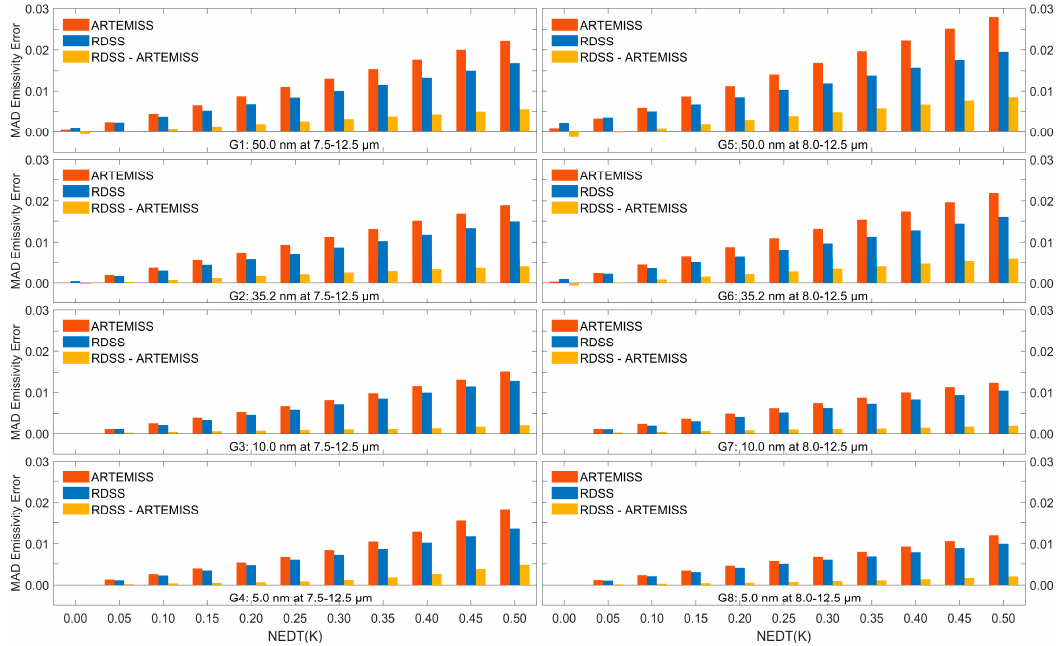
Figure 9 . A comparison of the retrieved LSE MADs using the RDSS and ARTEMISS algorithms. Figure 9. A comparison of the retrieved LSE MADs using the RDSS and ARTEMISS Table 5 . The retrieved LSE MAD for the RDSS and ARTEMISS algorithms and their differences.